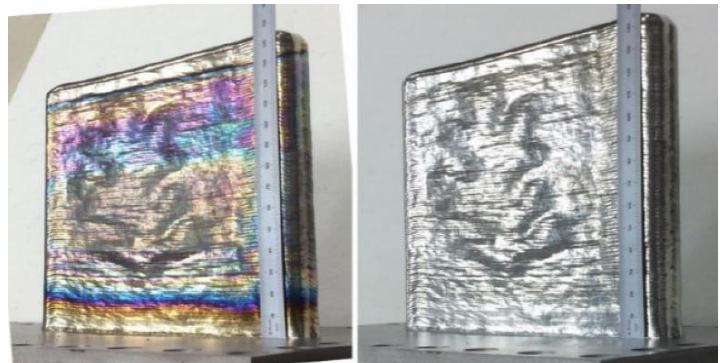
Figure 7. Demonstration object. Left : as constructed. Right : after post-processing heat treatment. Gibson et al. [37].